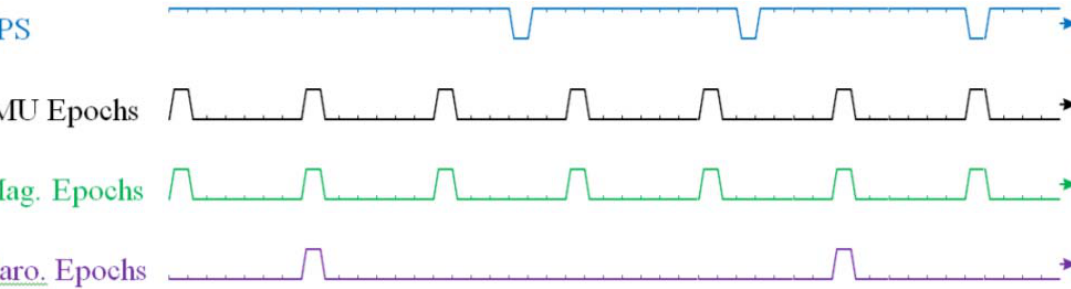
Figure 4. ASP PPS and Sensor Epoch Alignment